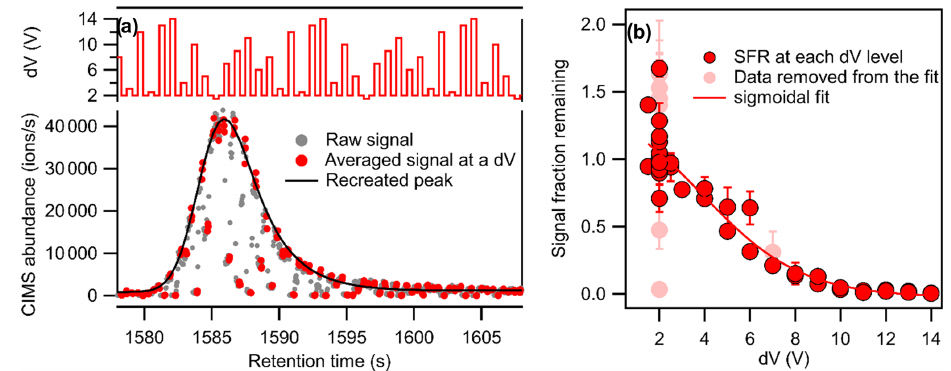
Figure 1. Demonstration of the voltage scan method to the GC-CIMS with (a) recreation of the chromatographic peak (grey dots represent all data collected at 20Hz, while the larger red dots represent the last three data points at each d V level, which are used to calculate the signal at the given d V level) and (b) signal fraction remaining at each voltage difference (d V ). Data points in light red, excluded from the sigmoidal fit, are signals from each d V level that do not meet quality control